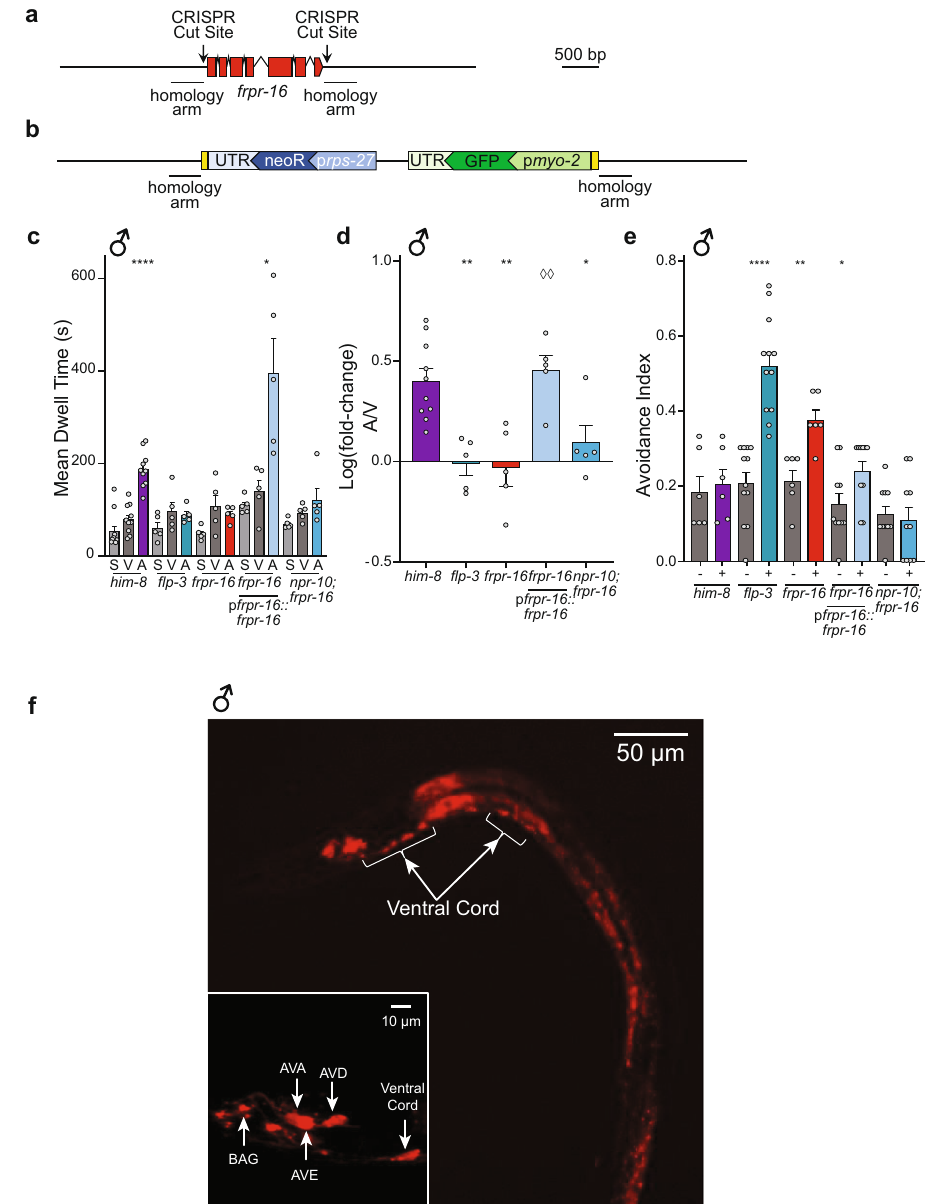
Fig. 5 FRPR-16 is required for the male behavioral response to ascr#8. a , b Design of CRISPR/Cas9-mediated frpr-16 null mutation construct. a The wild- type gene, with CRISPR cut sites marked, along with 450 bp homology arm regions. b The mutant gene sequence, consisting of an inverted cassette driving loxP fl anked p myo-2 ::GFP and p rps-27 ::neoR expression. c , d frpr-16 lof male animals display loss of attraction to ascr#8 and rescue of frpr-16 under its endogenous promoter rescues the attraction phenotype. frpr-16;npr-10 double mutant animals do not display an additive phenotype in terms of attraction c Raw dwell time and d log(fold-change) values. e frpr-16 lof male animals display increased avoidance to ascr#8 and rescue of frpr-16 restores avoidance to wild-type male animals. frpr-16;npr-10 double mutant animals do not display avoidance to ascr#8. f Expression pattern of p frpr-16 :: frpr-16 ::SL2::mCherry in male C. elegans at ×20 magni fi cation. Localization within the ventral cord denoted. f (inset), Amphid localization of p frpr-16 :: frpr-16 ::SL2::mCherry at ~×120 within the reverse locomotion command interneurons, AVA, AVE, and AVD, as well as the BAG neuron (anterior to the nerve ring). In panel d ◊◊ p < 0.01 for frpr-16 lof mutant versus transgenic rescue. ♂ denotes male